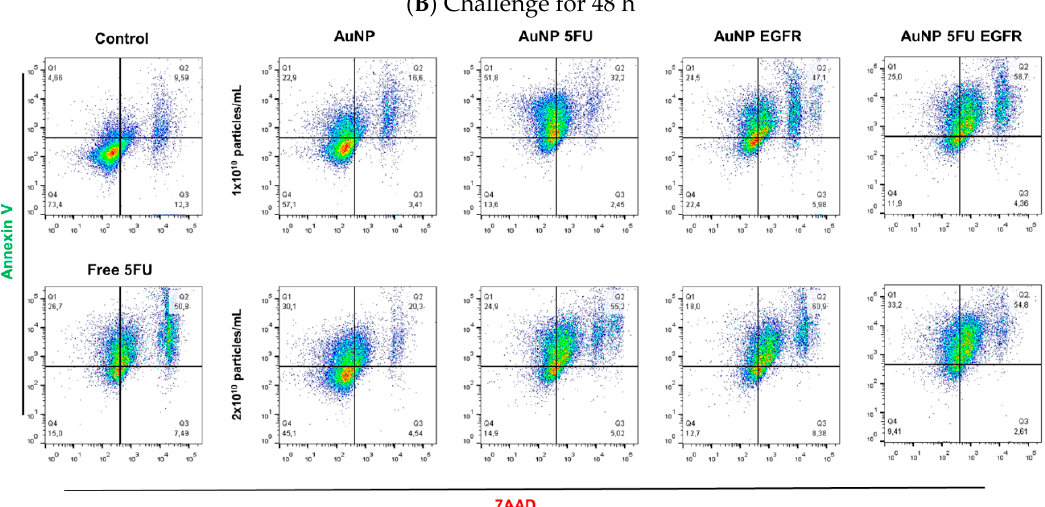
Figure 2. Representative assay of apoptosis and necrosis of HT-29 cells induced by free 5FU, AuNP, AuNP 5FU, AuNP EGFR or AuNP 5FU EGFR at the concentrations of 10 10 and 2 × 10 10 particles/m, for 24 h ( A ) or 48 h. ( B ). Our analysis by flow cytometry shows the efficiency of the AuNP 5FU EGFR and AuNP EGFR to increase the number of cells under late apoptosis with less than 10% viable cells at the highest concentration tested (representative data of three replicates).